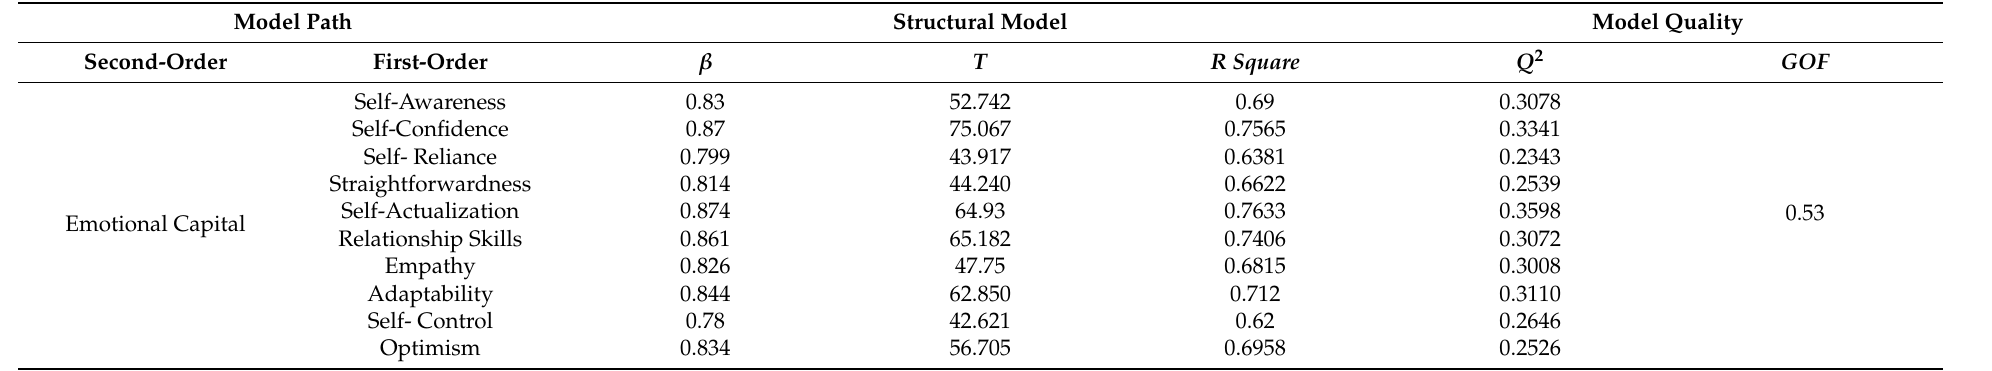
The convergent validity column and the diagonal of the table are bolded. Table 6. Structural model quality indices and structural model fitting of emotional capital and components. Model Path Structural Model Model Quality Second-Order